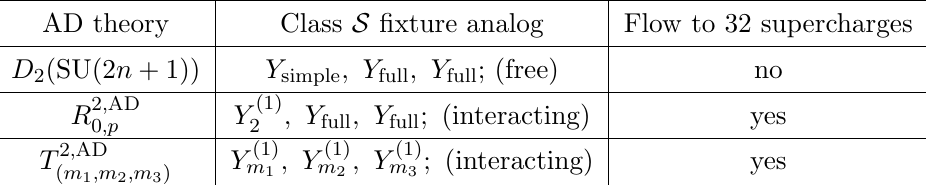
Table 1 . Three important classes of isolated SCFTs we study in this paper are in the leftmost column (note that we assume, without loss of generality, that m 3 (cid:21) m 2 (cid:21) m 1 ; these quantities obey further constraints discussed in the main text). The middle column indicates the corresponding regular puncture class S (cid:12)xture (speci(cid:12)ed by a triple of Young diagrams) in the sense described in section 3, where Y ( ‘ )